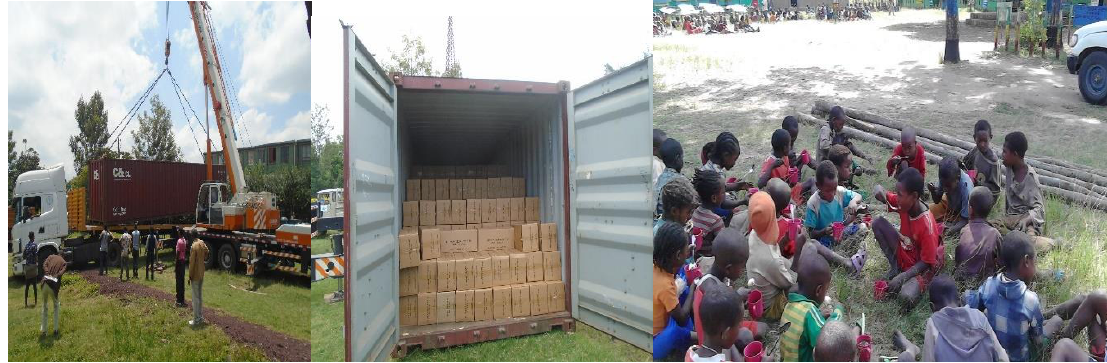
Figure 7. School feeding at Boricha district in 2016. Source: archive from Abenezer Rehabilitation and Development Association (ARDA).